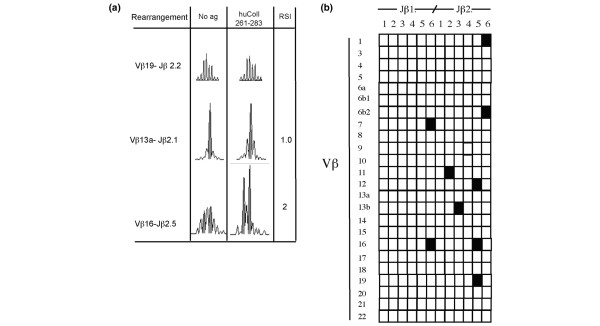
TCR repertoire usage in the immune response to huCollp263–271. PBMCs from patient OE were prepared as described in the Materials and methods section and cultured at 5 × 106 cells/ml in the presence or absence of 20 μg/ml huCollp263–271. Three days later cells were harvested and modified CDR3 β-chain spectratyping was performed, as described in Materials and methods. (a) Exemplificative BV-BJ CDR3 length spectra of T cells obtained for three rearrangements, in the absence and in the presence of antigenic peptide. The peaks interrupting the Gaussian distribution of CDR3 length (in an antigen-dependent or antigen-independent manner) are shaded in grey, and the RISs are shown. (b) Complete immunoscopy analysis of the immune response to huCollp263–271. Black squares indicate BV-BJ rearrangements, showing antigen-driven expansion (RSI ≥ 2) of one or more peaks. Rearrangement BV19-BJ2.5 exhibited an antigen-driven expansion of a peak of 99 bbases in length. In addition, expansion of two peaks of 96 and 105 bases in length was observed, with RSI 1.8. huCollp261–273, human collagen peptide 261–273; PBMC, peripheral blood mononuclear cell; RSI, rate stimulation index.